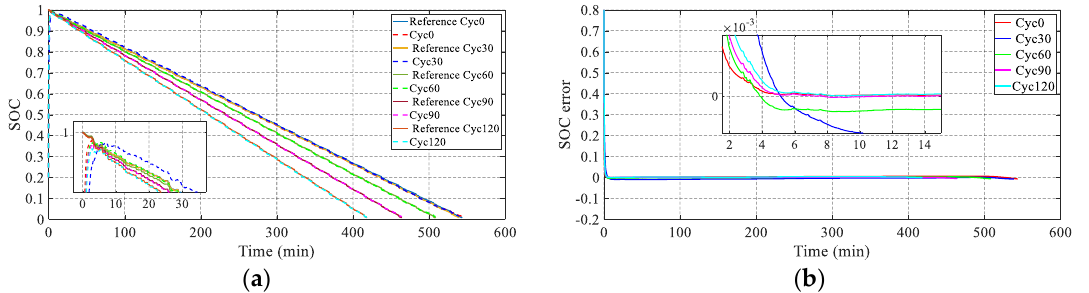
Figure 9. Capacity value of measurement and estimation at various degradation extents. ( a ) Estimation results; ( b ) Relative error.